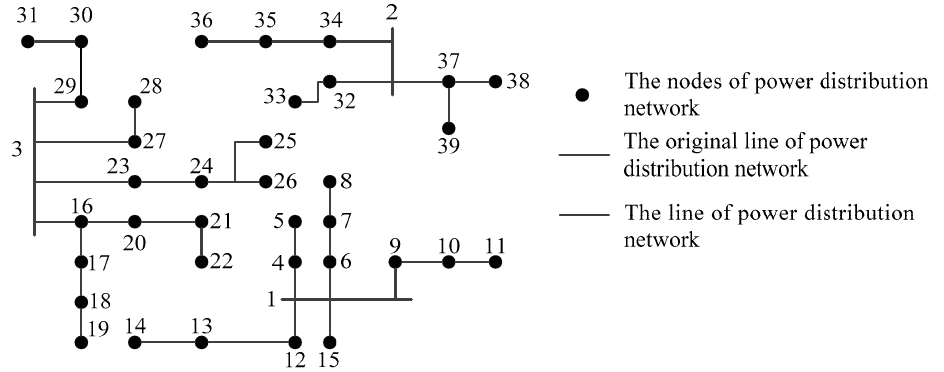
Figure 3. Nodes of the power distribution network.